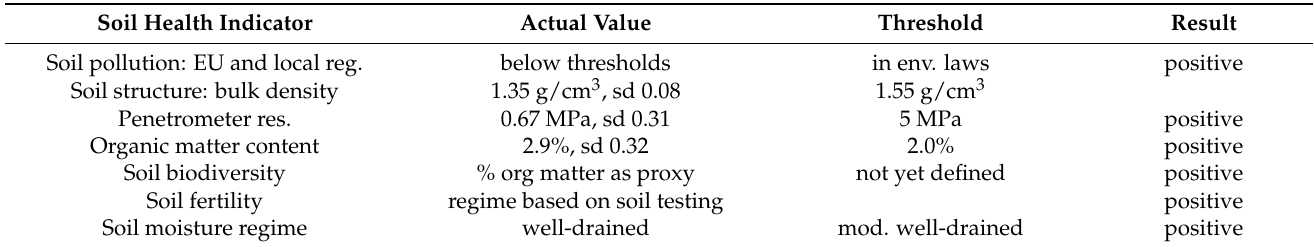
Table 1. Soil health indicators for the Living Lab described in the text. Conclusion: this soil was healthy and offered a positive entry point for SDG15 in terms of the lack of soil